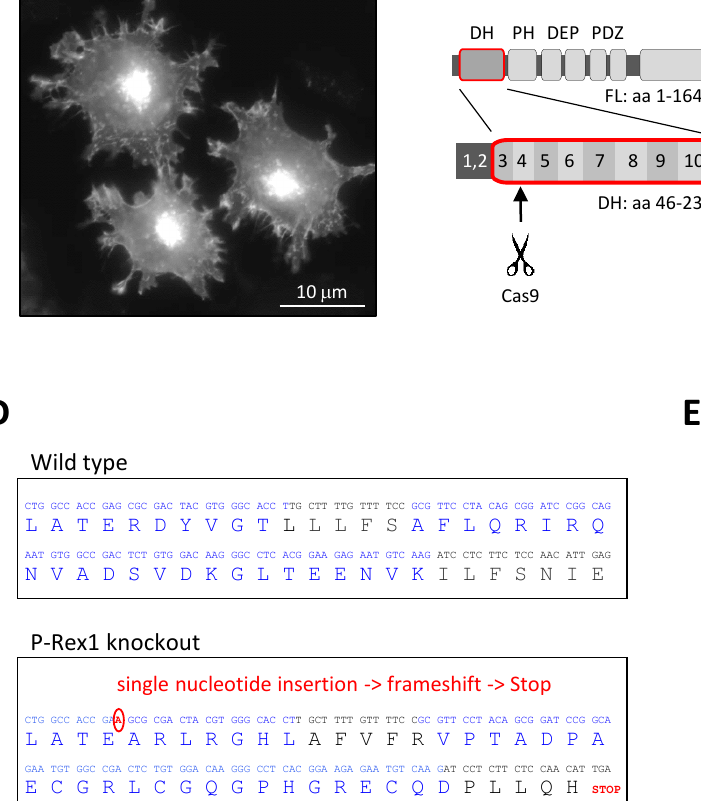
Figure 1: Generation of P-Rex1 deficient PC12-S1PR cells